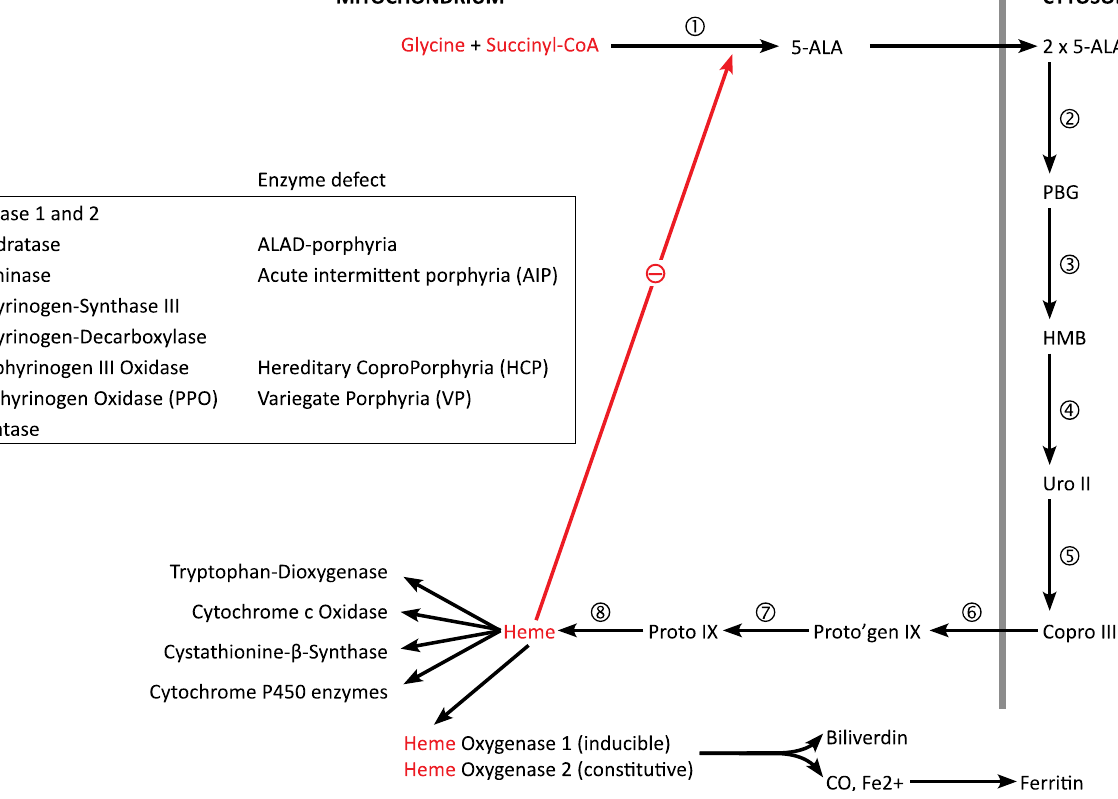
Figure 2. Biosynthesis of heme: the first four enzymes occur in tissue specific isoenzyme forms. d-ALA = d-aminolevulinic acid, PBG = porphobilinogen, HMB = hydroxymethylbilane, Uro III = Uroporphorinogen III, Copro III = Coproporphorinogen III, Proto = Protoporphyrin (ogen) IX. The en-